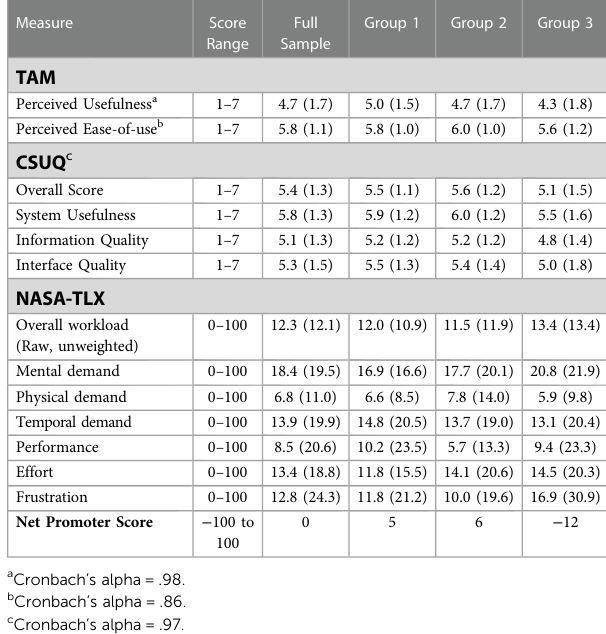
TABLE 4 Measures scores, M (SD